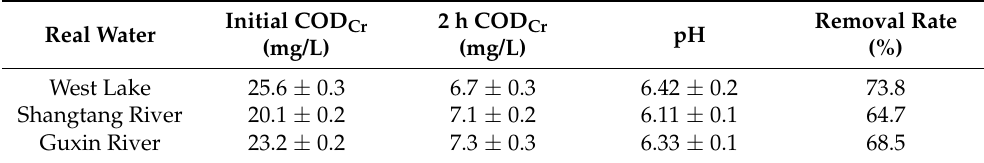
Table 1. Photocatalytic activity of 8 wt%-120-PVA/TiO 2 in natural water.